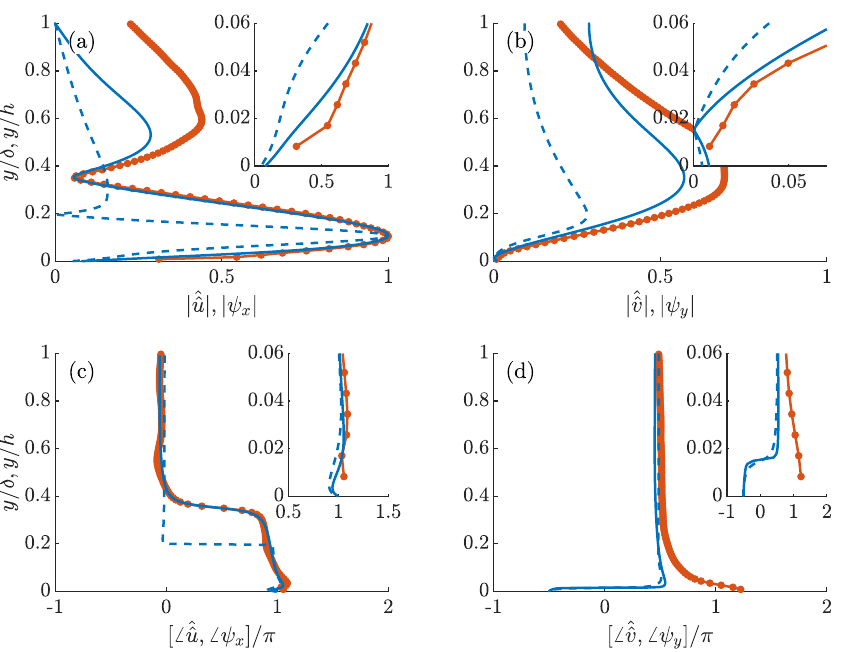
Figure 8. Comparison of the ( a , b ) amplitude and ( c , d ) phase between the experimental results (red solid lines with circle markers), the resolvent modes (blue dash lines), and the resolvent modes with eddy viscosity (blue solid lines) for the compliant wall. Figures ( a , c ) are the streamwise modes, and ( b , d ) are the wall-normal modes. Markers for the experimental results indicate locations where measurements were taken. Mode amplitudes are normalized by their peak streamwise amplitude, and phases are matched at the peak location. Insets are the near wall close-up views for y / h , y / δ ≤ 0.06. Parameters for the resolvent analysis are Re τ = 410, ( k x , k z , c + ) = ( 2.78,0,14.08 ) , and Re τ = 410, ( k x , k z , c + ) = ( 2.78,0,15.15 ) , without and with eddy viscosity,